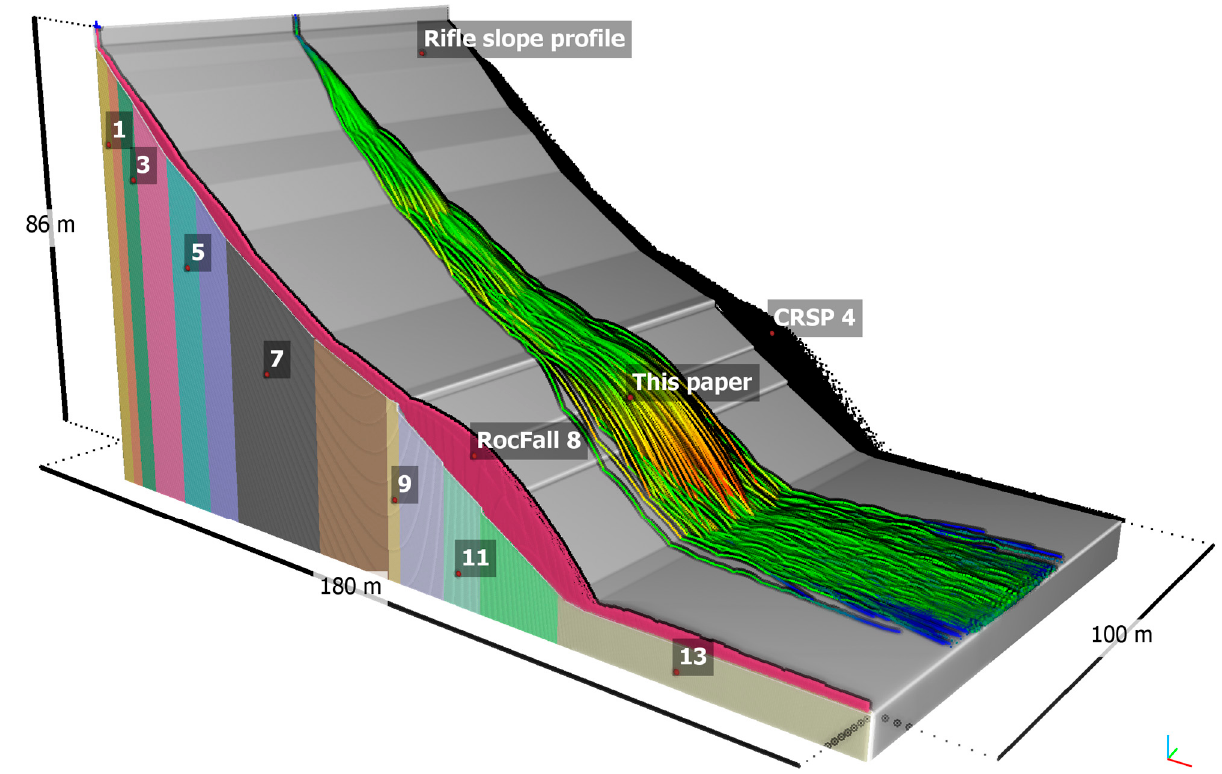
Figure 20. Rifle rockfall test site used for the comparison. The different cells with attributed terrain materials are shown with vertical colored bands and numbers. The 10,000 trajectories simulated with each software and the presented algorithm (this paper) combined with the same impact model as the others are shown in magenta for RocFall 8, in graded colors for the proposed algorithm and in black for CRSP 4. The results of CRSP 4 were created using the original damping coefficients and artificial terrain roughness for the 13 cells found to reproduce the data from the original rockfall experiment performed at that site [6,16,17]. Surprisingly, they had to be modified to new adjusted values with RocFall 8 and the proposed algorithm to produce the results shown above, which match the CRSP 4 results.